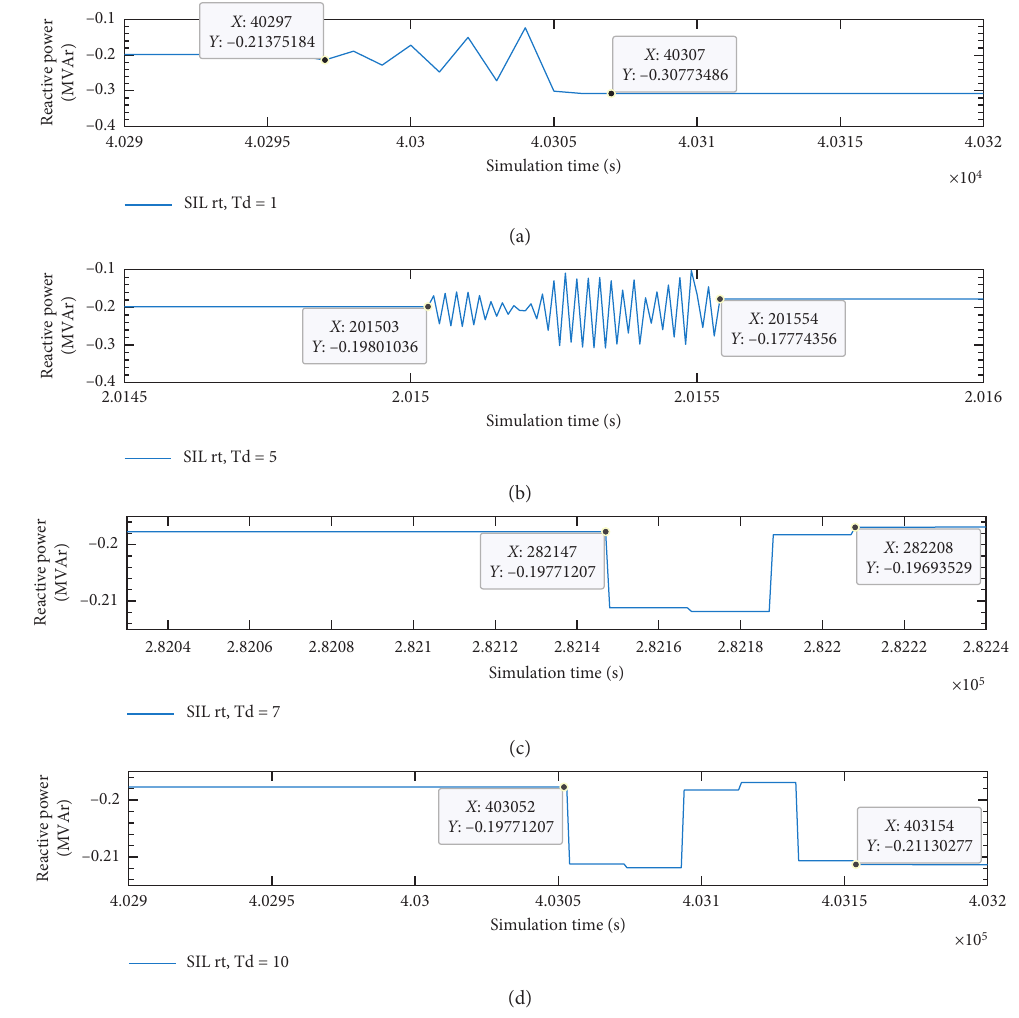
Figure 15: Results from the real-time SIL real-time test. Reactive power flow at the WTconverter between 4029h and 4031 h when T 7, and 10.